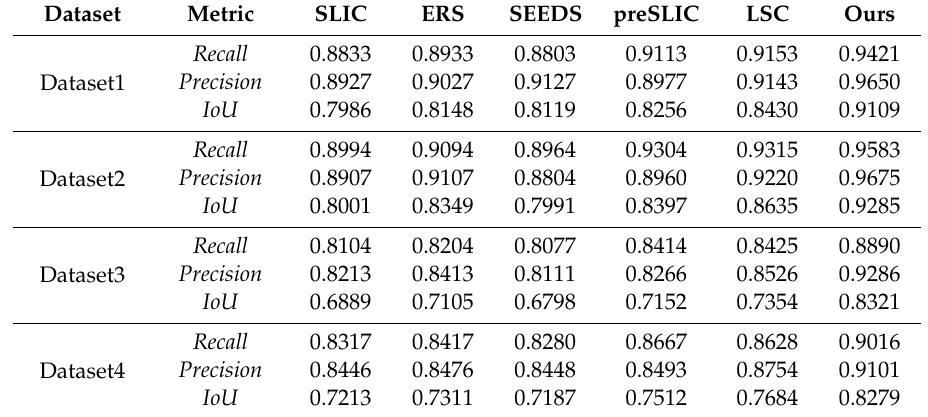
Table 4. Superpixel-based building extraction results on the four datasets before regularization stage.